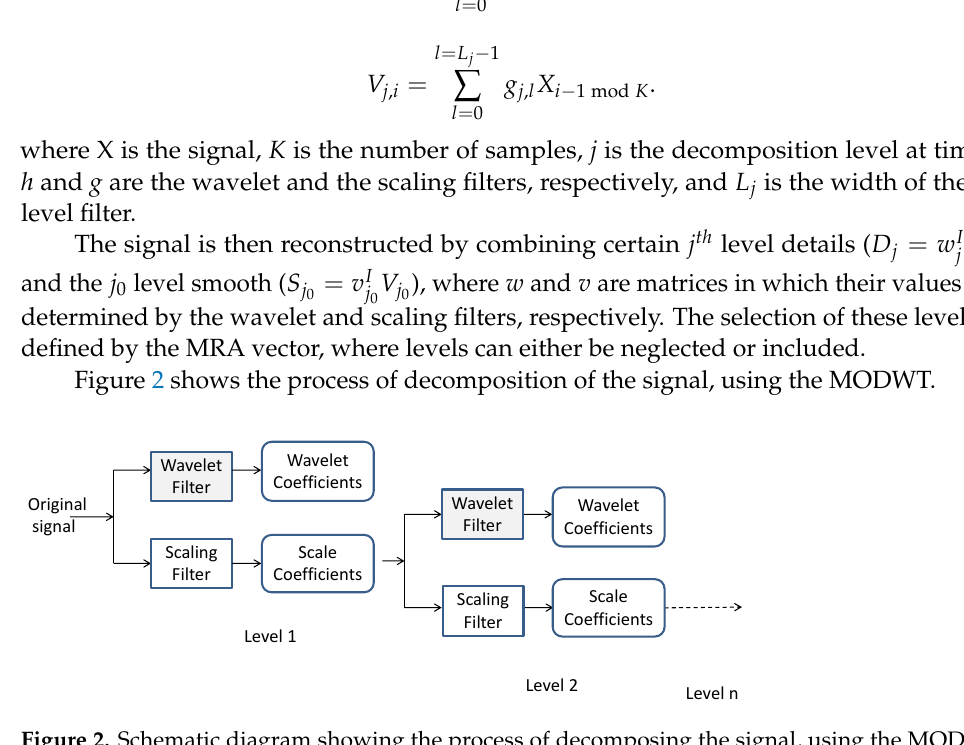
Figure 2. Schematic diagram showing the process of decomposing the signal, using the MODWT